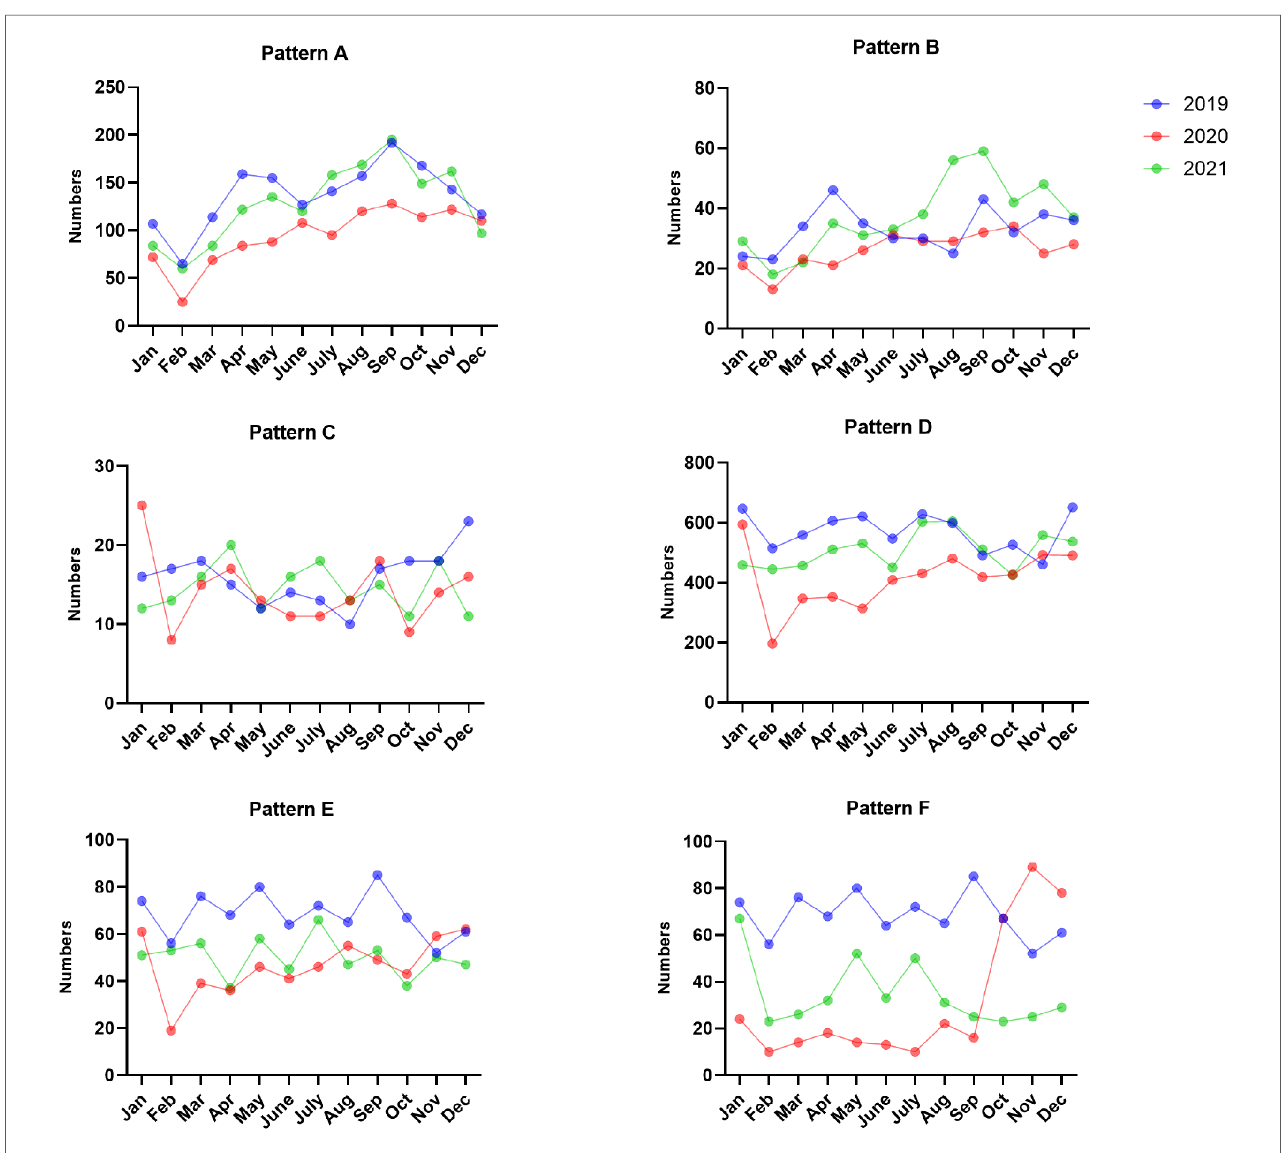
FIGURE 4 The numbers of EBV antibody patterns based on months between January 2019 and December